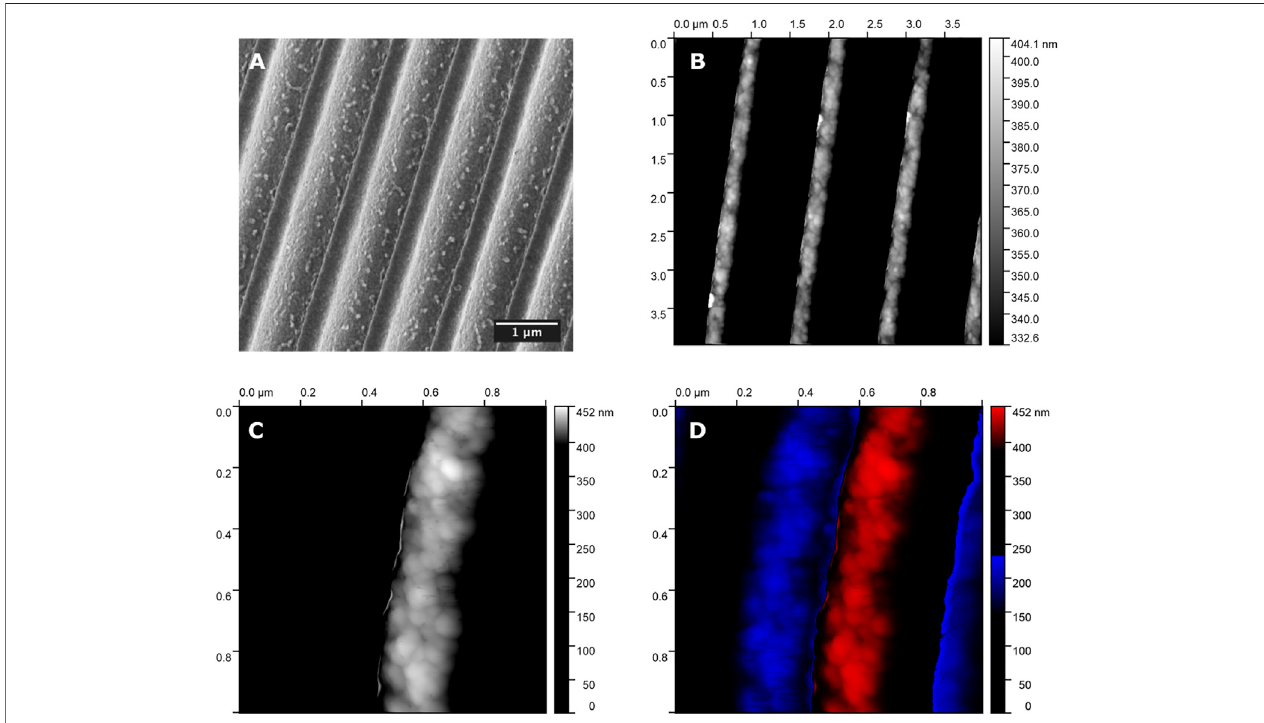
FIGURE 4 | (A) SEM image of the nanoMIP ’ s functionalized nanograting. AFM images of the nanoMIP ’ s of the functionalized nanograting: (B) Top view of the nanoMIP-nanograting; (C) expanded view of the top of one single nanostripe with particular focus on the nanoMIPs (mean d (cid:2) 30 nm) coupled to the nanostripe; (D) expandedviewonthetopofonenanostripe,depictedinred,withevidenceonthecouplednanoMIPsand fl ankedbythetwovalleysofthenanogratingstructure,thatare represented in blue.